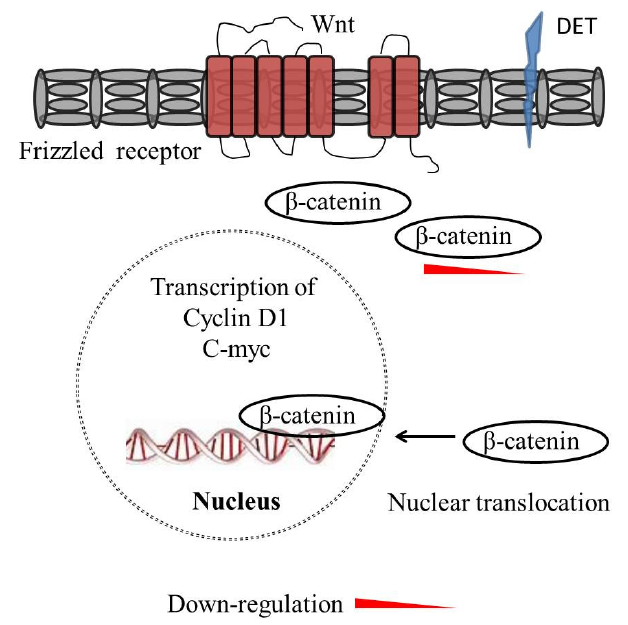
Figure 4. DET inhibits Wingless-Integrated/ β -catenin (Wnt/ β -catenin) signaling in cancer cells. The Wnt/ β -catenin signaling pathway is involved in the regulation of various biological processes including cell division, migration, and fate determination during embryonic development. Over-expressed β -catenin regulates the transcription of oncogenes, including cyclin D1 and c-myc. DET downregulated the expression of β -catenin, cyclin D1, and c-myc.